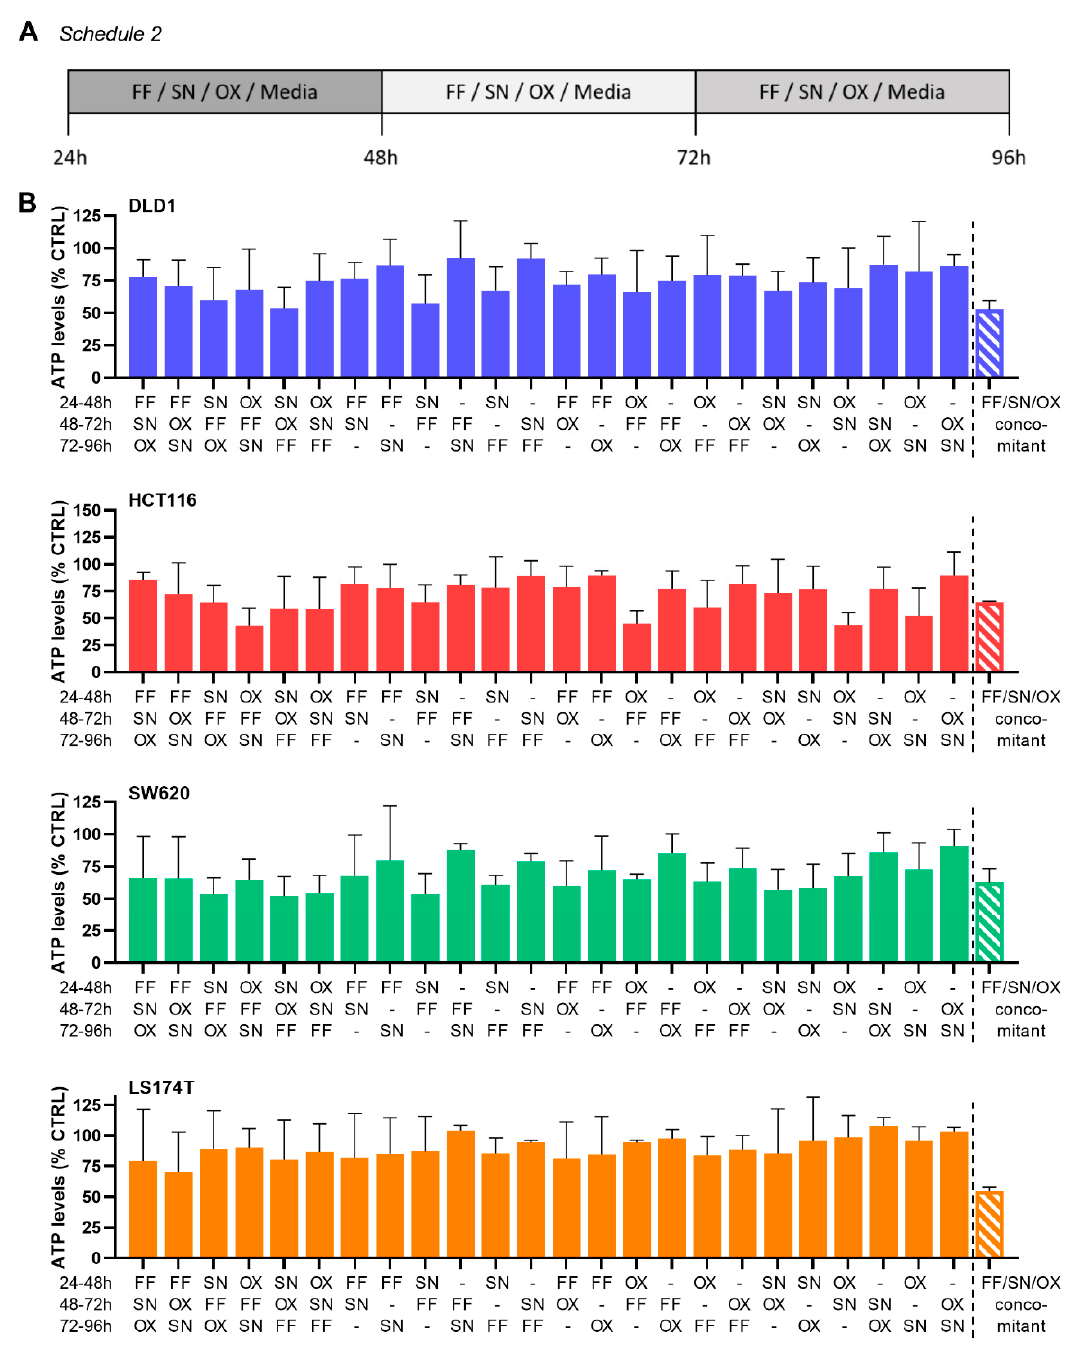
Figure 5. Sequential drug administration of the ODCs. ( A ) Schematic representation of the sequential drug administration of folinic acid and 5-fluorouracil combined (FF), SN-38 (SN), oxaliplatin (OX) and medium in 24 h intervals (Schedule 2), and ( B ) the drug combination efficacy on cell metabolic activity for each of the cell lines. Error bars represent the SD for N = 3 experiments. No statistically significant difference was observed between the conditions tested.